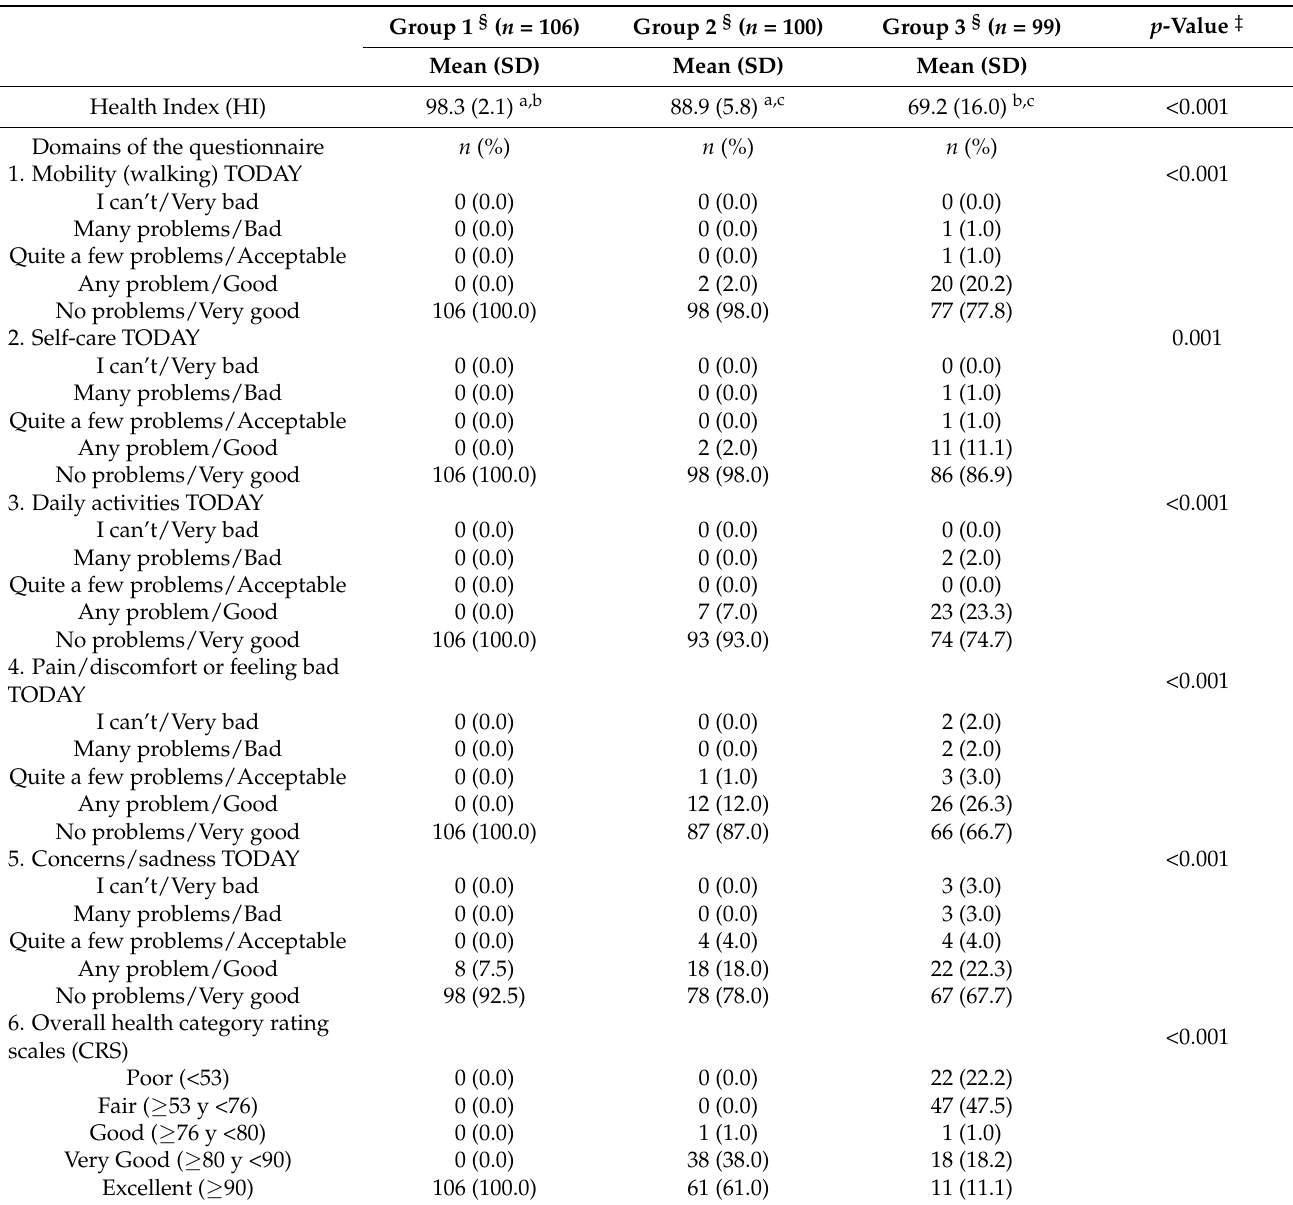
Table 2. Answers of the EQ-5D-5L of children according to health-related quality of